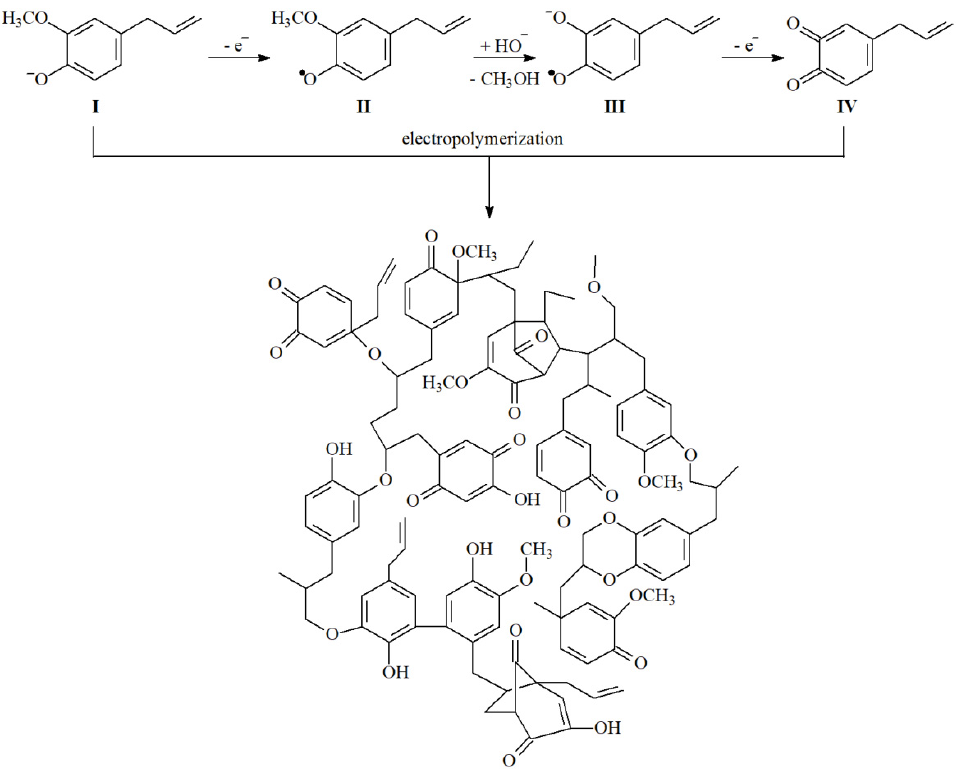
permission from the American Chemical